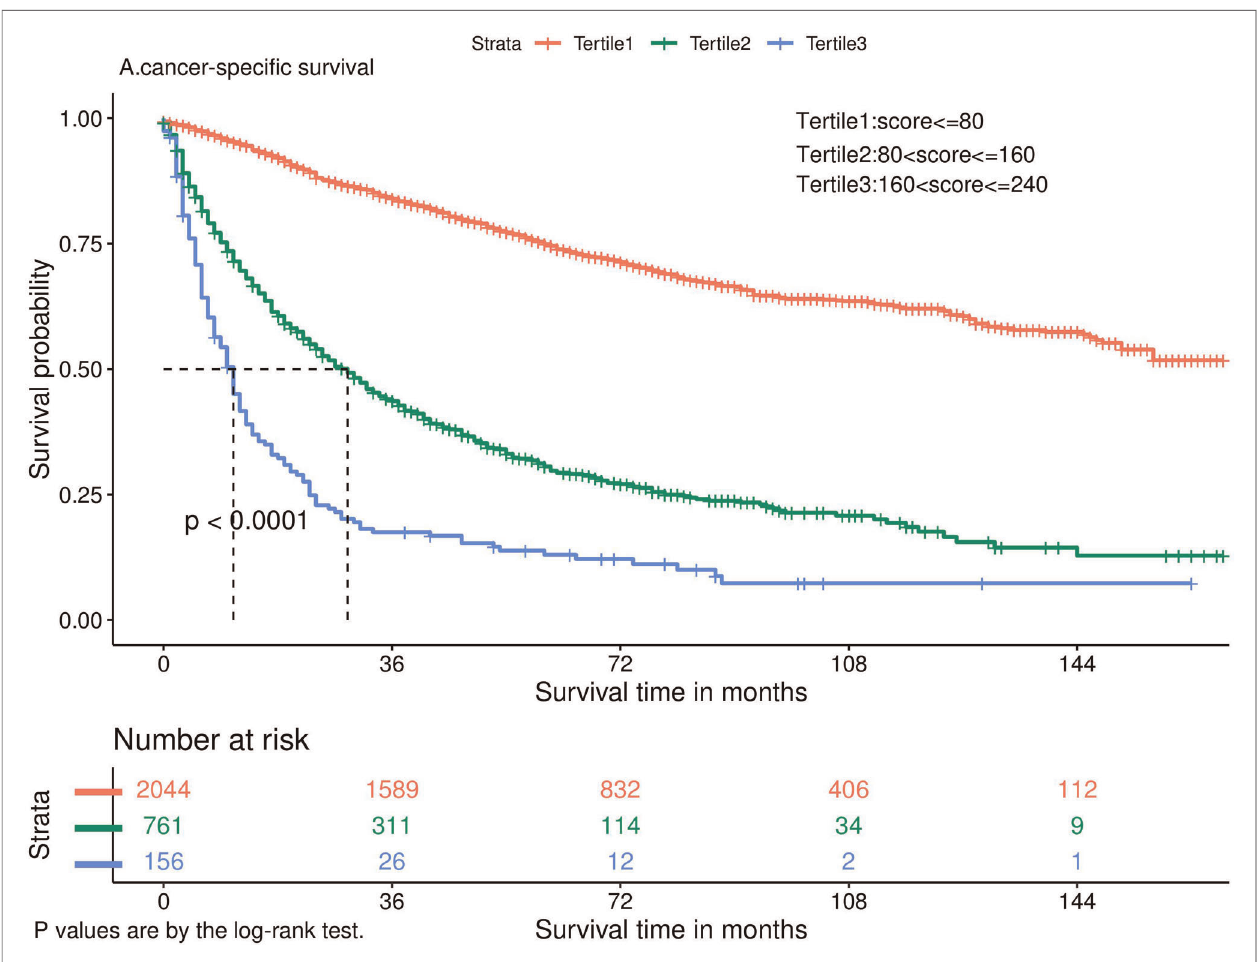
FIGURE 3 | Kaplan-Meier